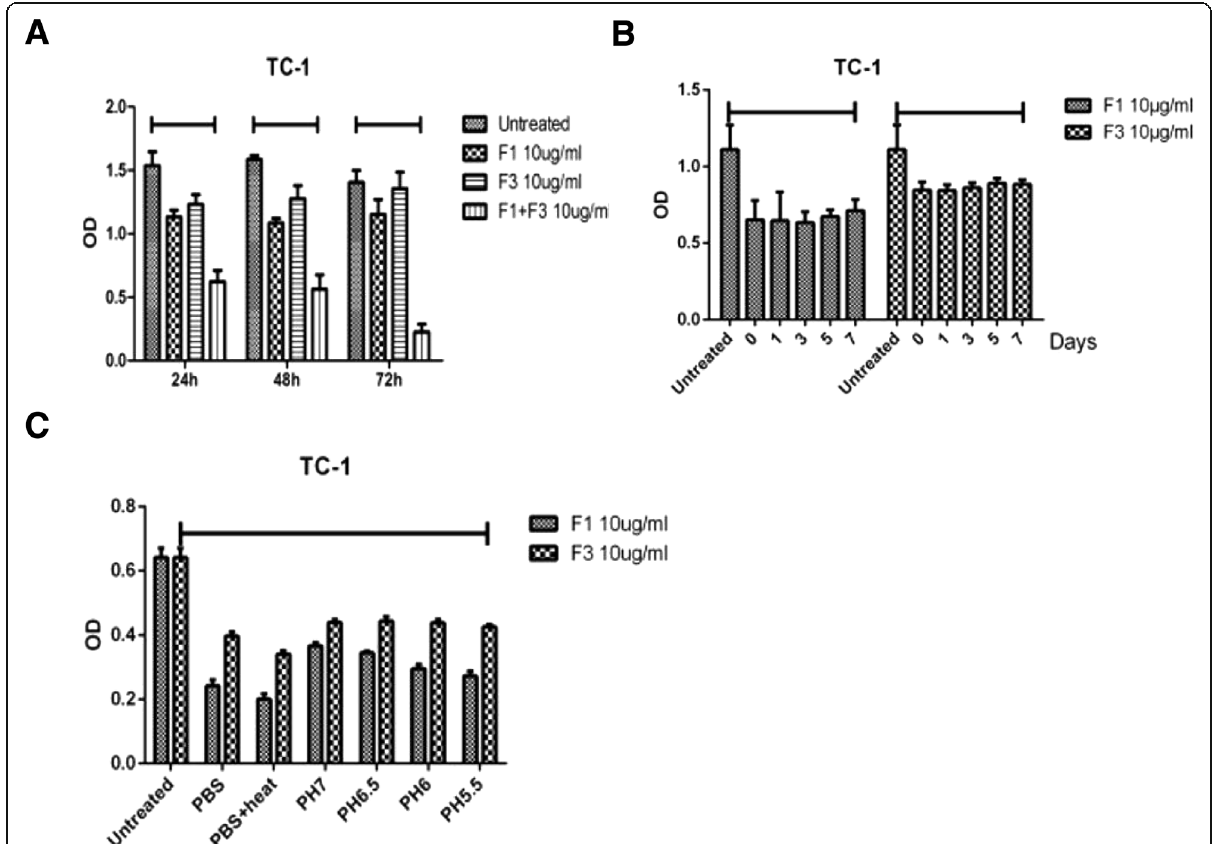
Fig. 3 Caerin peptides are stable 5 or 10 μ g of Caerin 1.1 (F1) and Caerin 1.9 (F3) peptides were added to 8 × 10 3 of TC-1 cells in flat bottomed 96 well plates and cultured overnight at 37 °C with 5% CO 2 . Cell proliferation was determined by an MTT assay. ( a ): MTT assay after TC-1 cells were incubated with Caerin 1.1 for 24 – 72 h. ( b ): Caerin 1.1 and 1.9 were left at room temperature for up to 7 days before processing to an overnight MTT assay. ( c ): MTT assay after the pH of the PBS was adjusted to acidic condition (from pH 7.4 to pH 5.5), and after the Caerin 1.1 and 1.9 was heated at 100 °C for 15 min. *: P < 0.05; **: P < 0.01; ***: P <